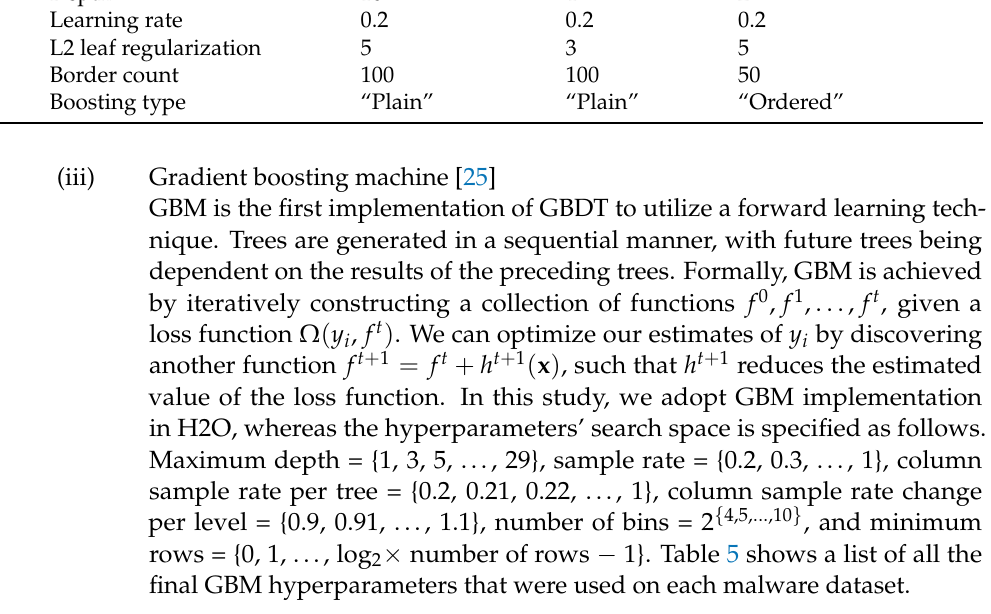
Table 5. The final learning parameters of GBM used for each dataset after performing random search .